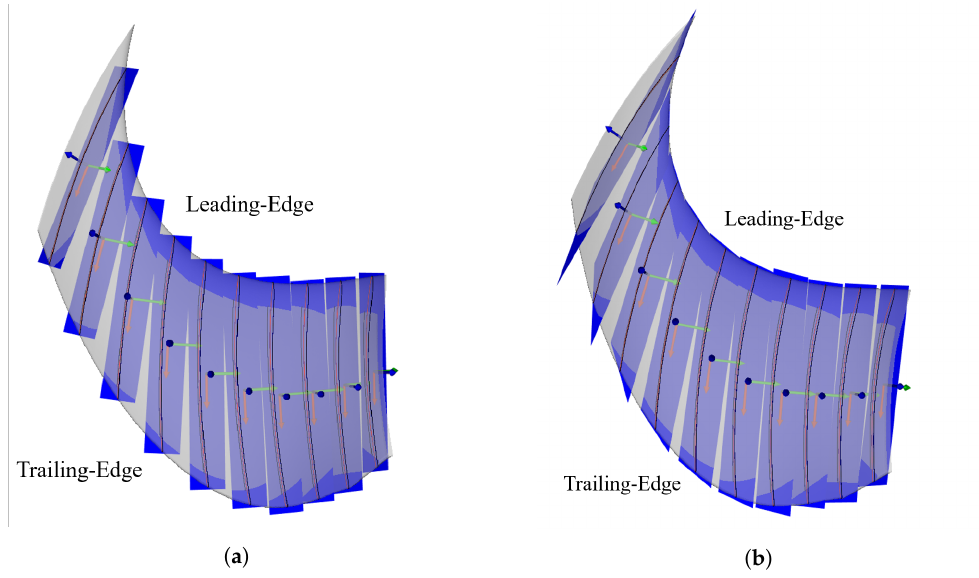
Figure 7. For the leading-edge case, the blade is divided into 10 segments: in ( a ), a classical unswept leading-edge formulation can be used; in ( b ), the effect of the sweep is evaluated with blade strips which have locally parallel leading-edges, following the blade forward-skewed